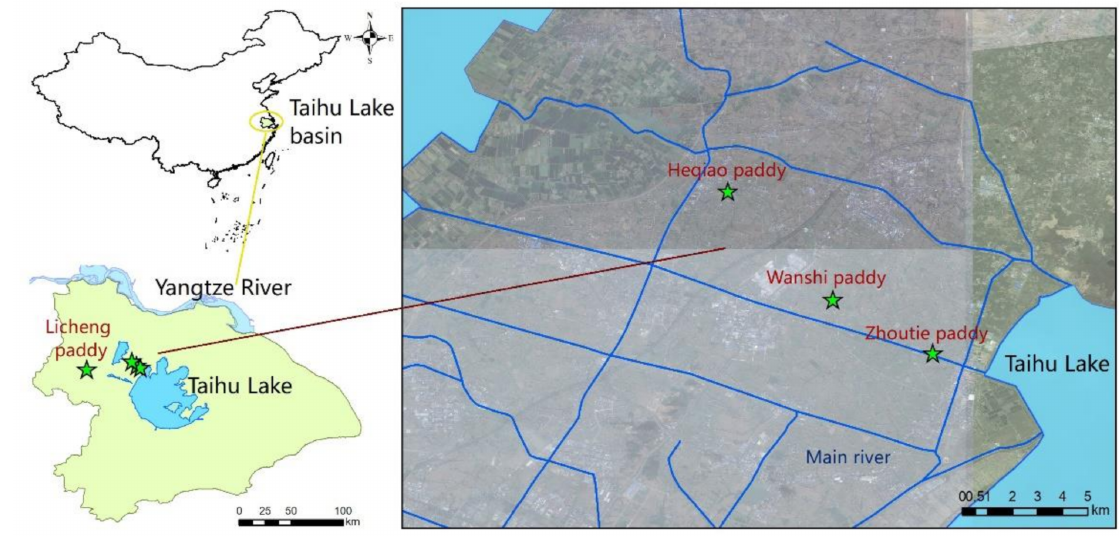
Figure 1. The location of Taihu Lake basin in China and the paddy